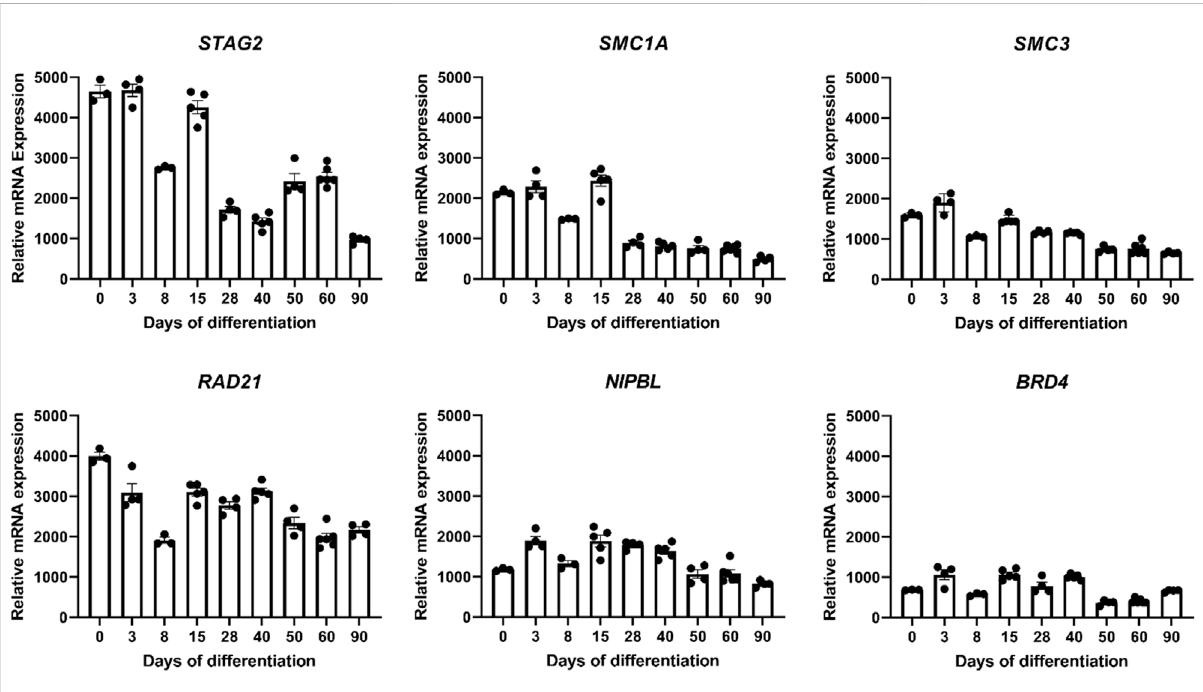
FIGURE 6 Transcriptome analyses during Bioengineered Neuronal Organoid (BENO) generation (from day 0 to day 90) by RNA sequencing. Transcriptome analysis of core subunits of the cohesin complex STAG2, SMC1A, SMC3 , and RAD21 , and interaction partner NIPBL that cooperates with BRD4 during BENOs development (D0, undifferentiated iPSC; D3-15, neuroectoderm commitment; D28-40, neurogenesis; D50-90, gliogenesis and neuronal